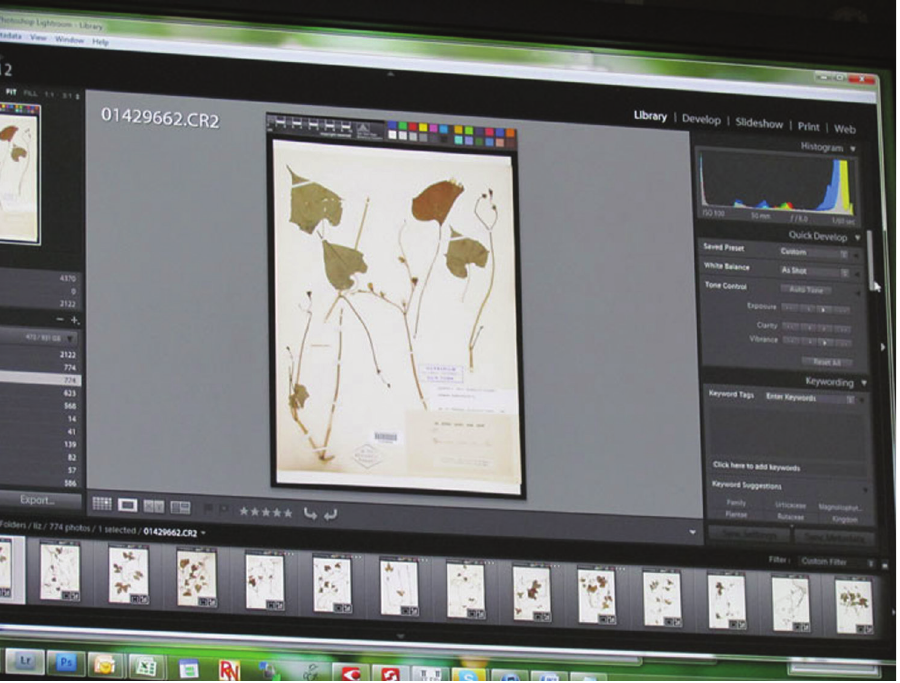
Figure 4. Specimen image processing. Using Adobe Photoshop Lightroom software to process images. New York Botanical